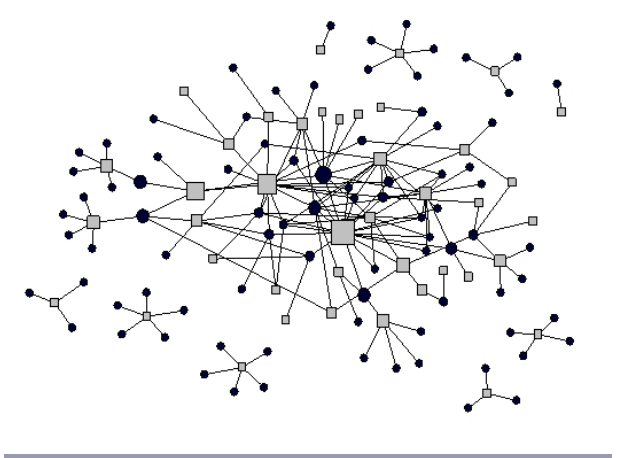
Fig. 3 . Network of interaction between researchers and policy makers participating in the bridging organization (Decision Center for a Desert City [DCDC]). Researchers are represented by squares and policy makers by circles. The size of the node indicates its relative betweenness- centrality (a formal network measure), which in turn is an indication of how well this actor connects other actors in the network. Actors with a high betweenness-centrality can be said to play a potentially important role as liaisons and brokers in a network of collaborating